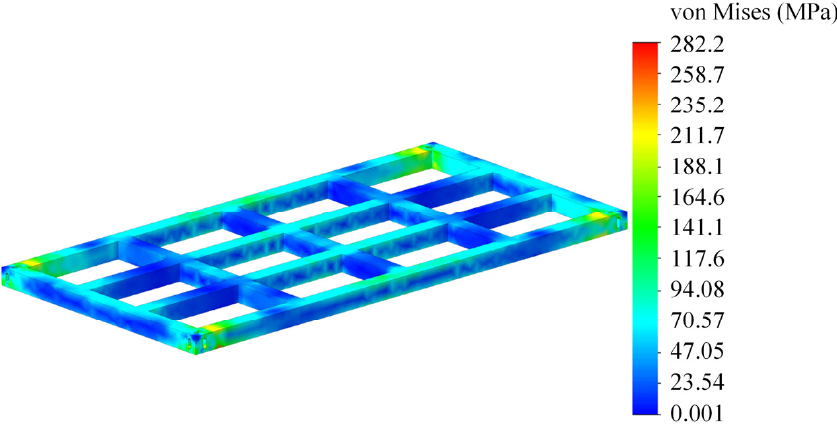
Figure 14. Stress–strain state of the removable module.